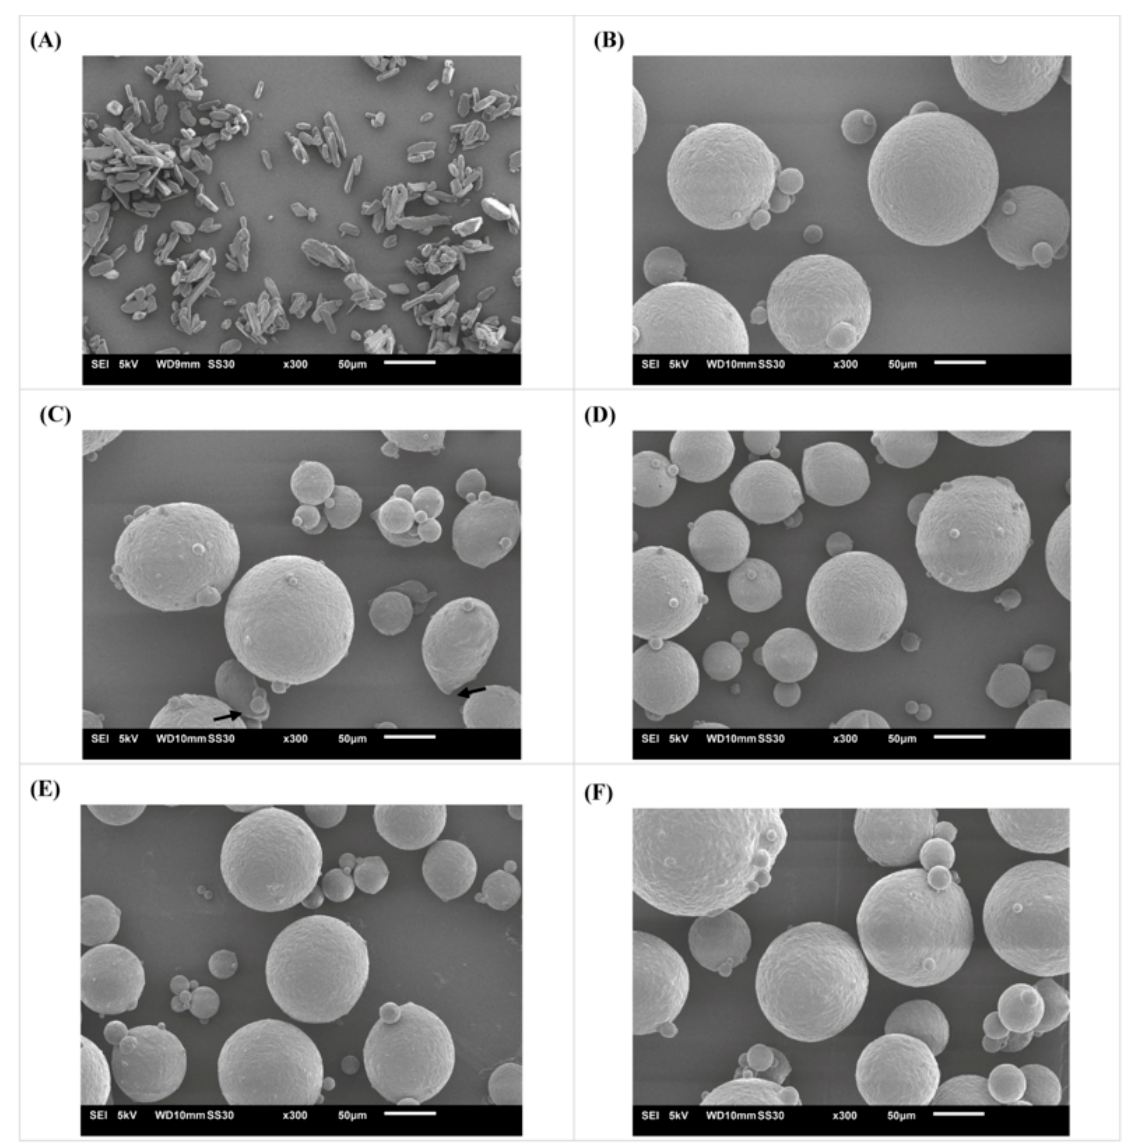
Figure 7. Scanning electron microscope images of ( A ) paracetamol; ( B ) blank PW59